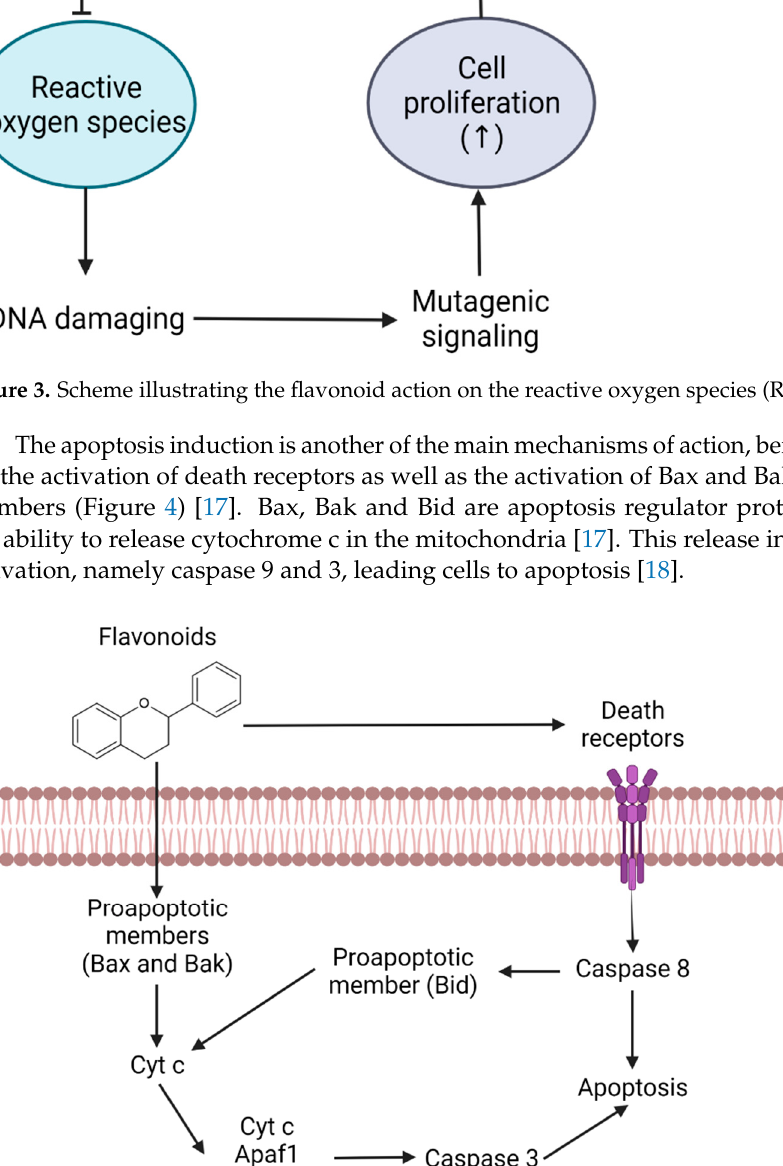
Figure 4. Representation of the apoptotic pathway mediated by flavonoids.